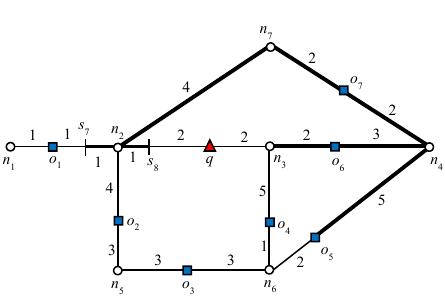
Figure 5. Influence region of o 2 .